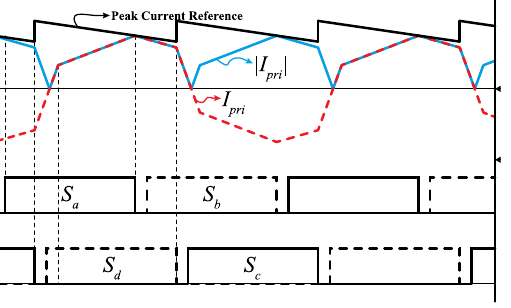
Figure 8. Primary-side current waveform with slope compensation for PCMC-based PSFB